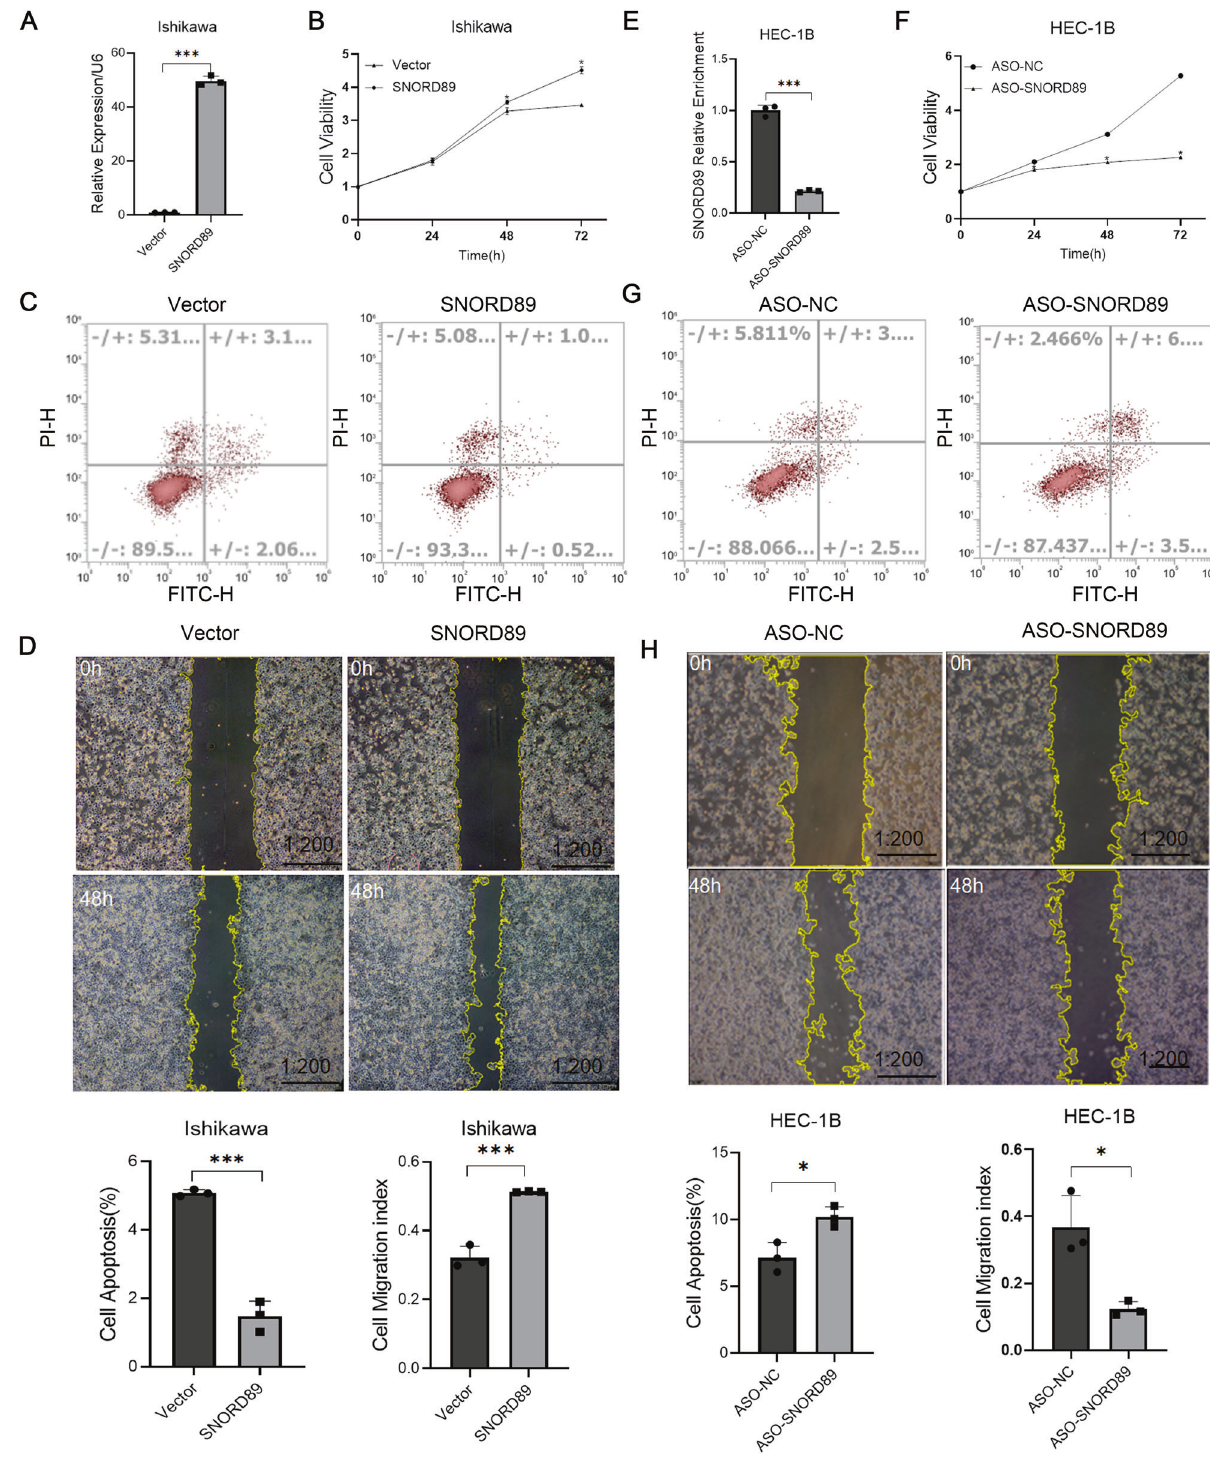
Fig. 2 Effect of SNORD89 on EC cells in vitro. A Transfection ef fi ciency after overexpression of SNORD89 ( n = 3); B SNORD89 overexpression induced cell viability ( n = 3) and D cell migration ( n = 3), C while reduced cell apoptosis ( n = 3). E Transfection ef fi ciency after downregulation of SNORD89 ( n = 3); SNORD89 downregulation reduced F cell viability ( n = 3), H cell migration ( n = 3), while increased G cell apoptosis ( n = 3). Values are presented as the mean ± SD. * p ≤ 0.05; ** p ≤ 0.01; *** p ≤